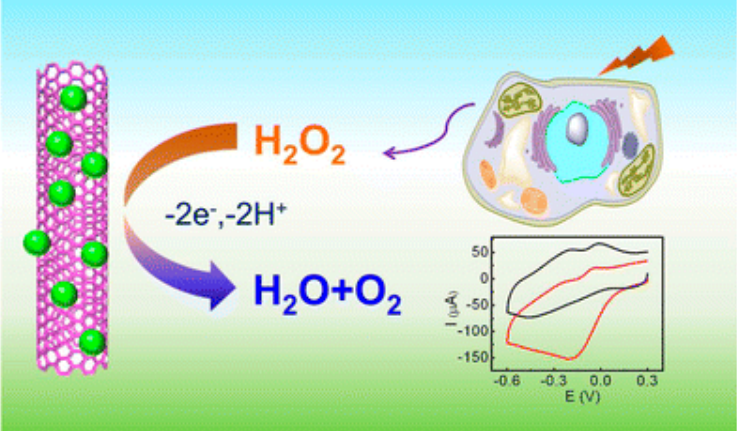
27 of 44 Figure 6. Enzyme-loaded CNTs for the detection of H 2 O 2 in living cells. Reproduced with permis- sion from [336]. Copyright 2019, Elsevier Ltd (Amsterdam, The Netherlands). 3.5.2. H 2 O 2 Electrochemical Sensors Based on the Association of Metallic Nanoparticles and CNTs In the last few years, the connotation of metal nanoparticles with CNTs has been con- sidered a valuable alternate for the development of highly sensitive and selective sensors